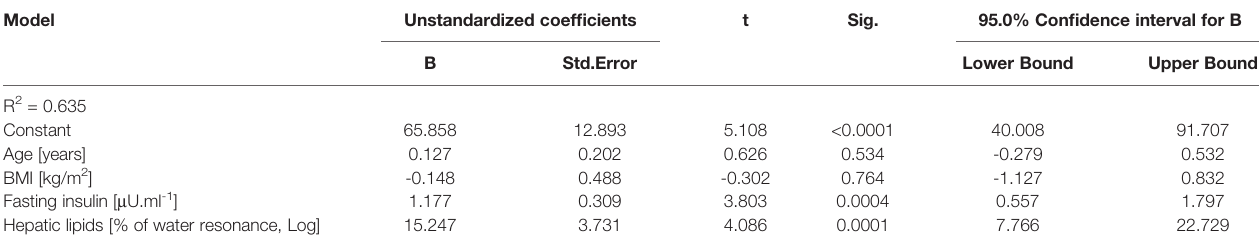
TABLE 3 | Regression analysis showing independent predictors of serum afamin concentrations (using multiple linear regression analysis).